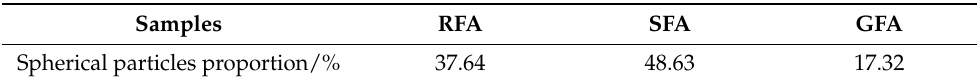
Figure 3. Calculation of spherical particles proportion using SEM-BSE images. From the spherical particles analysis of different fly ash, the average spherical particles proportion (spherical particles area to all particles area in 50 images) is listed in Table 4. Table 4. Spherical particles proportion of different fly ash.